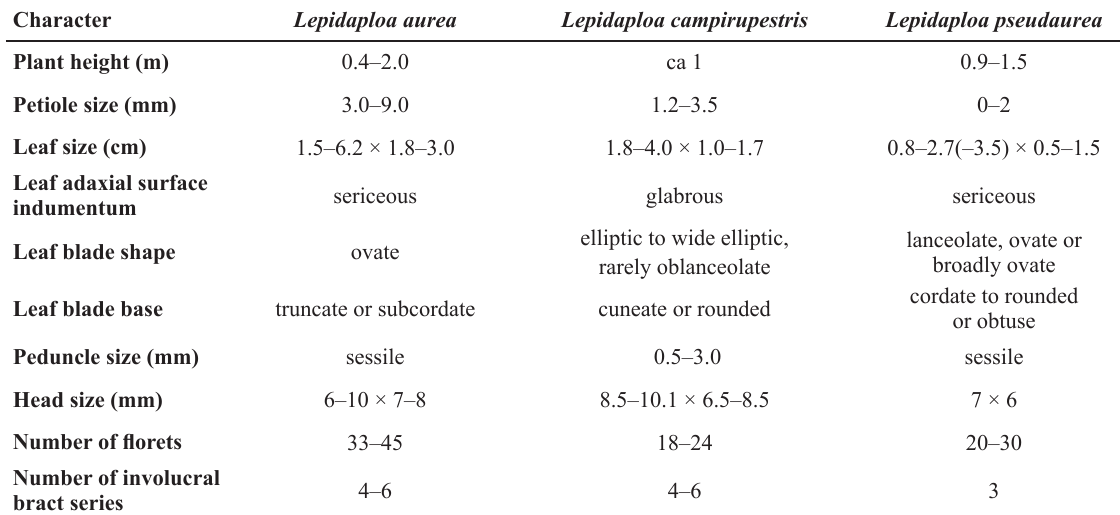
Table 1 – Diagnostic morphological characters of Lepidaploa campirupestris and related